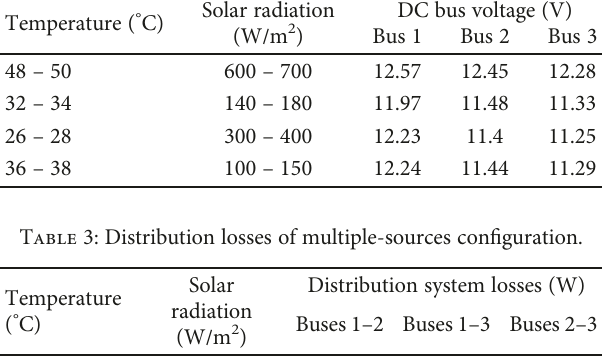
Table 2: DC distribution voltage of the existing single-source con fi guration.